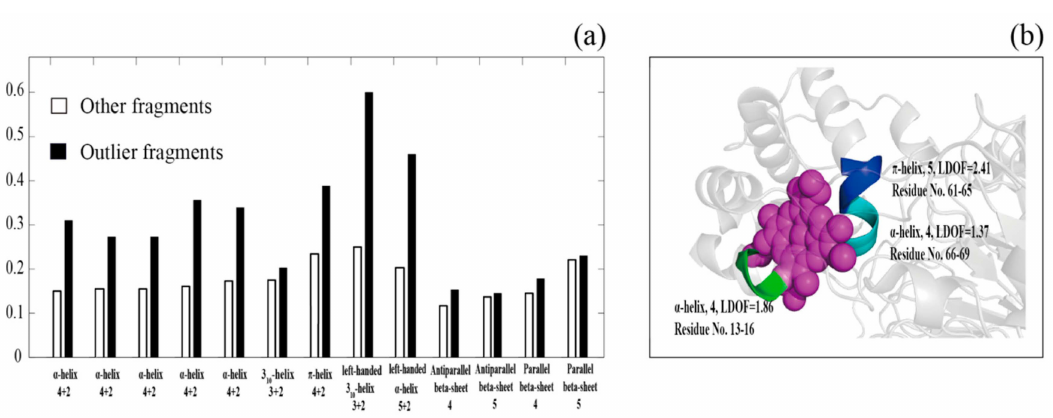
Figure 5. A histogram of the correlation between protein–ligand binding sites and two types of fragments: outlier fragments (black bar) and other fragments (white bar). ( a ) shows a histogram of the two types of fragments vs. a protein-ligand binding site. The x -axis is their secondary structure feature and length, while the y -axis is the probability of the secondary structure observed at the protein-ligand binding site (distance less than 4Å). Figure b shows an example illustrating the outlier poses detected at protein–ligand binding sites: for cytochrome cd1 nitrite reductase (pdb ID: 1qks), there are three outlier helix fragments (colored green, blue and cyan) around the binding site (the ligand is colored in purple). The LDOF values and residue index for the helix fragments are also labeled in figure b